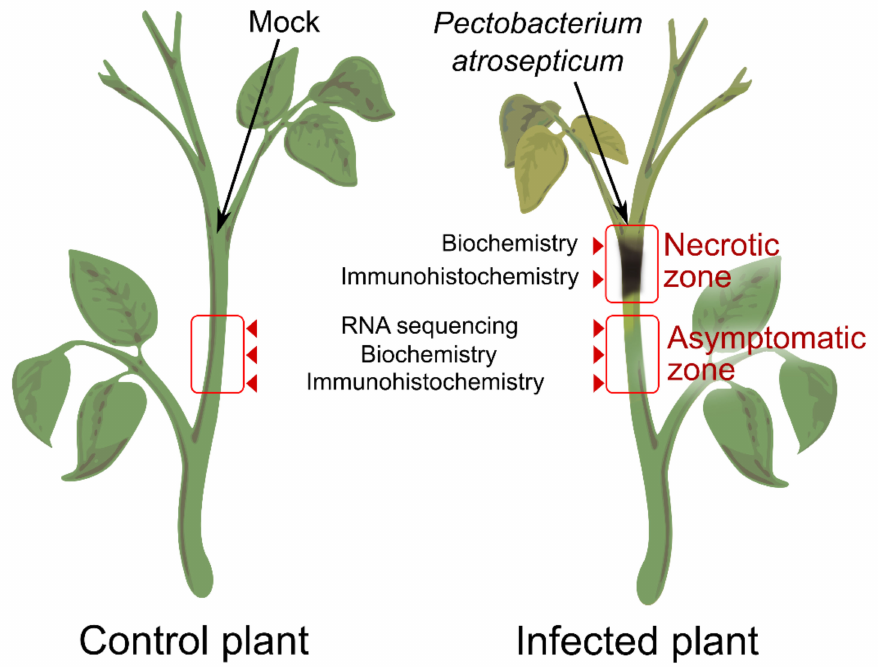
Figure 1. Scheme of the plant material ( Pectobacterium atrosepticum -infected and control potato plants) collection for the plant cell wall-related gene expression analysis as well as biochemical and immunolocalization analyses of the plant cell wall